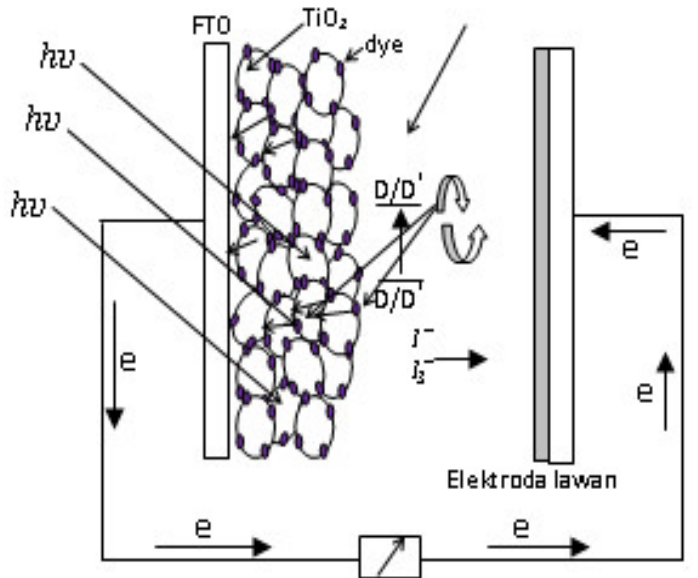
Figure 11. The working principle of dye-sensitized solar cells [172].